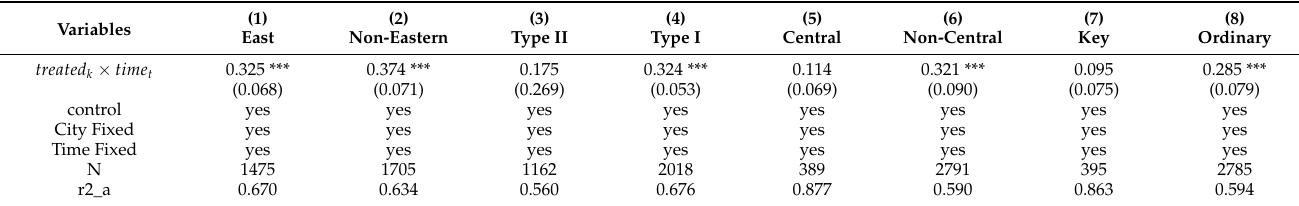
Table 8. Heterogeneity